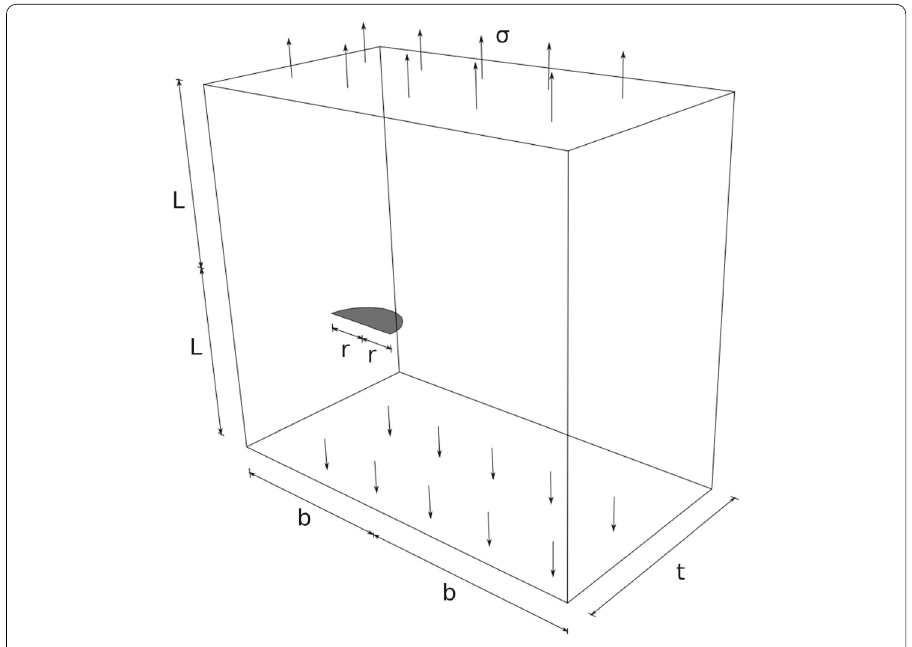
Fig. 13 Three-dimensional surface crack. This figure presents the geometry for a three-dimensional surface crack that is used to test HNA